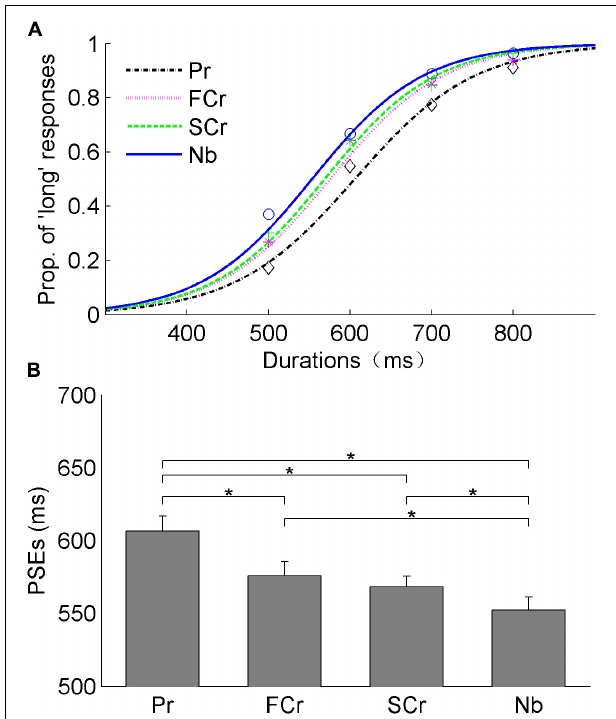
FIGURE 4 | Results of Experiment 2b. (A) The fitted curves plot the mean judgments for pseudoword repetition (“Pr”), first-character repetition (“FCr”), second-character repetition (“SCr”), and novel baseline (“Nb”). (B) The bars indicate the mean points of subjective equality (PSEs), and their corresponding standard errors in each condition (all * p <